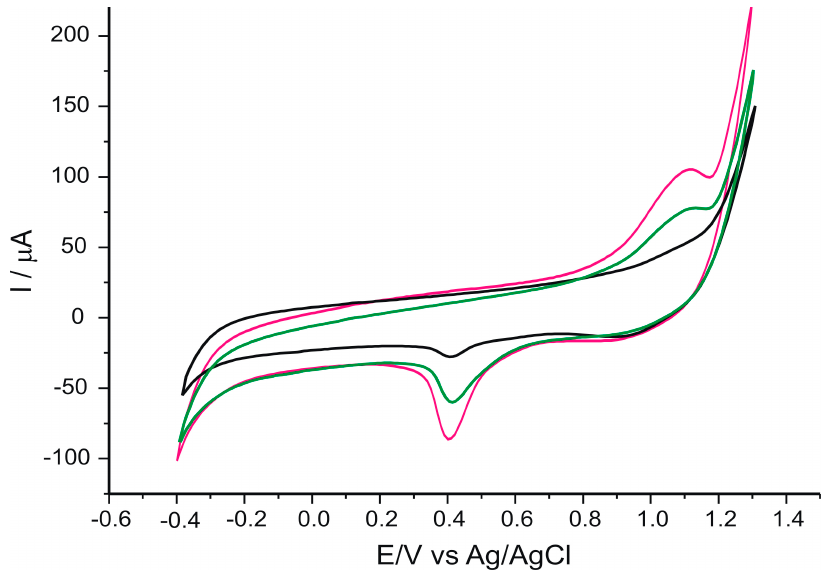
Figure 2. CVs of CNF-GNP/SPCE sensor when immersed in EVOO sample v2 (red line), POO sample p2 (green line) and SFO sample s2 (black line). Scan rate 0.1 V·s − 1 .